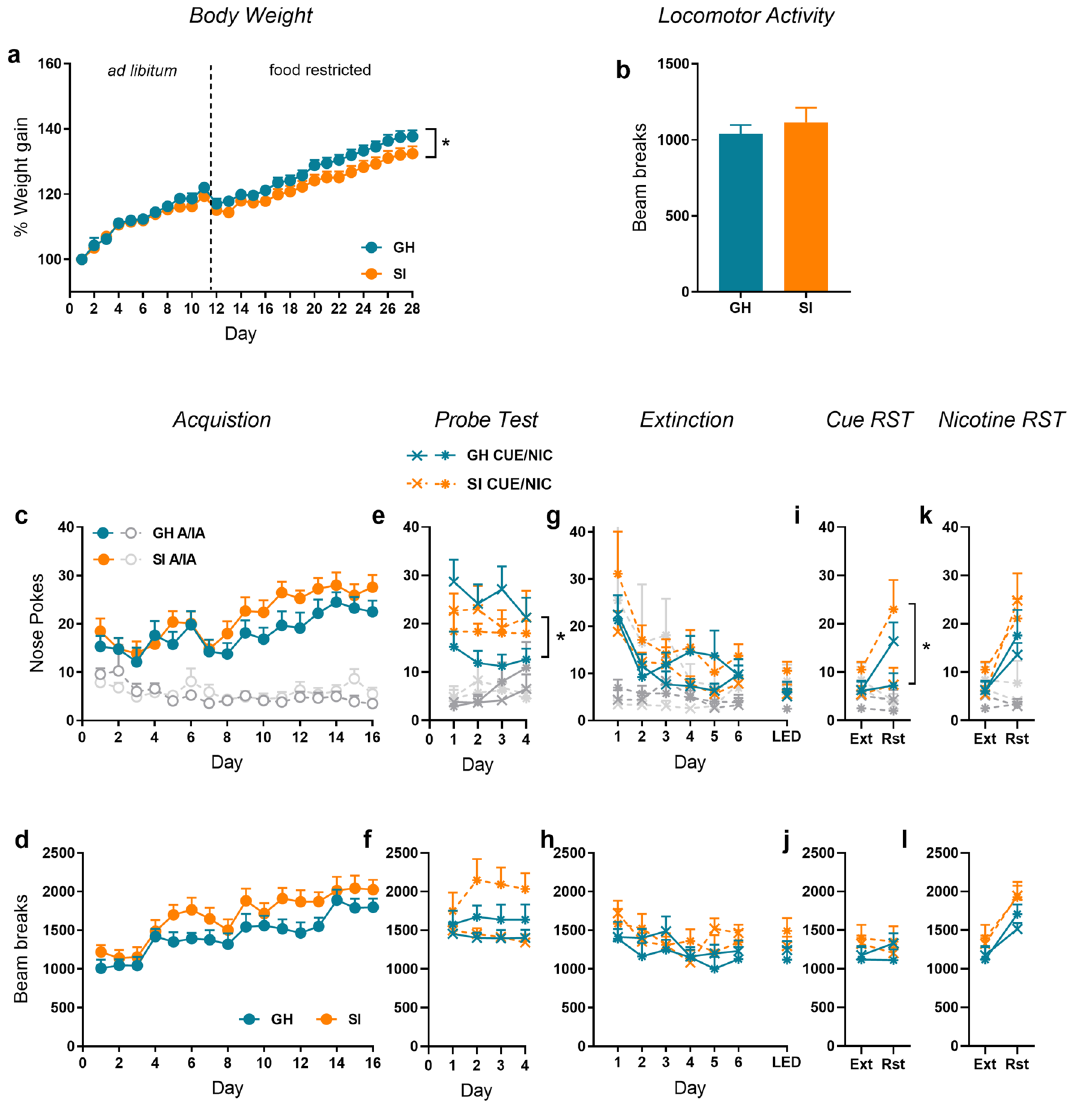
Figure 3. Experiment 2: The effect of social isolation on the acquisition and reinstatement of responding for intravenous nicotine. ( a ) Percentage weight gain across the entire study, including when food was freely available (ad libitum) and following restriction prior to operant training (food restricted). ( b ) Spontaneous locomotor activity during habituation to the instrumental chambers. Active (colour) and inactive (grey) nose- pokes and locomotor activity across acquisition ( c , d ), the probe test trial ( e , f ), extinction training ( g , h ), cue- reinstatement ( i , j ) and nicotine reinstatement ( k , l ). GH group housed, SI socially isolated, LED Last extinction day, EXT extinction, RST reinstatement. Asterisks indicate main effect or interaction involving housing condition where * p < 0.05, ** p < 0.01 or *** p < 0.001. n = 16/group except 8/group for the probe Experiment 3: The effect of social isolation on acquisition versus reinstatement of responding for a sucrose pellet. Body weight. Consistent with the previous experiments, SI rats gained less weight 2 than their GH counterparts (Fig. 4a; main effect of housing F(1,28) = 17.69, p < 0.001, η ρ = 0.39; day x housing 2 interaction: F(23,644) = 10.50, p < 0.001, η ρ = 0.27). This effect did not significantly change following the switch 2 of housing condition (main effect of housing 1; F(1,26) = 9.389, p < 0.01, η ρ = 0.26). Acquisition of instrumental conditioning. Socially isolated rats were more active during habituation to the oper- 2 ant chamber (Fig. 4b; F(1,29) = 7.435, p < 0.05, η ρ = 0.20). As with experiment 1, rats in the SI condition more rapidly acquired nose-poking for a sucrose pellet (Fig. 4c; 2 responses per min: main effect of housing: F(1,29) = 4.271, p < 0.05, η ρ = 0.13; nose poke x housing: F(1,29) = 4.829, 2 p < 0.05, η ρ = 0.14), although there were no differences in magazine entries per minute (Fig. 4d) or locomotor activity per minute (Fig. 4e).